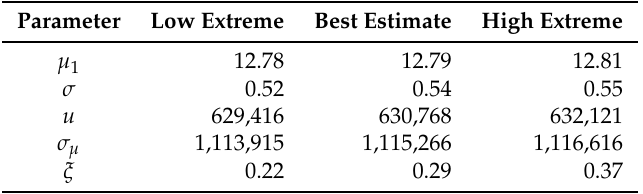
Table 7. Estimated parameters and 99% confidence intervals of Lognormal–GPD–Gamma distribution.